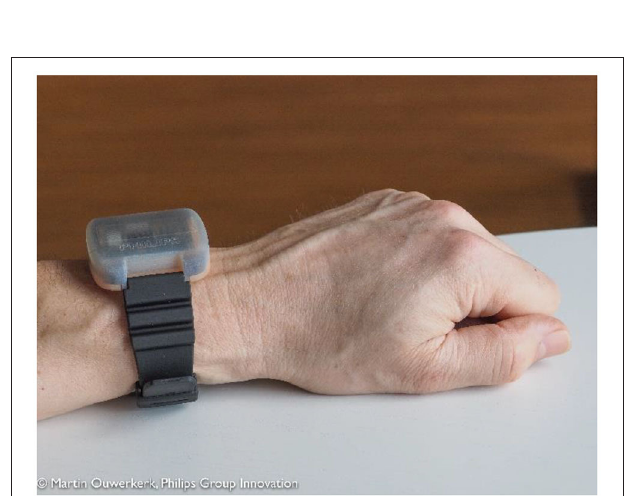
FIGURE 5 | The DTI-4 worn on the outside of the